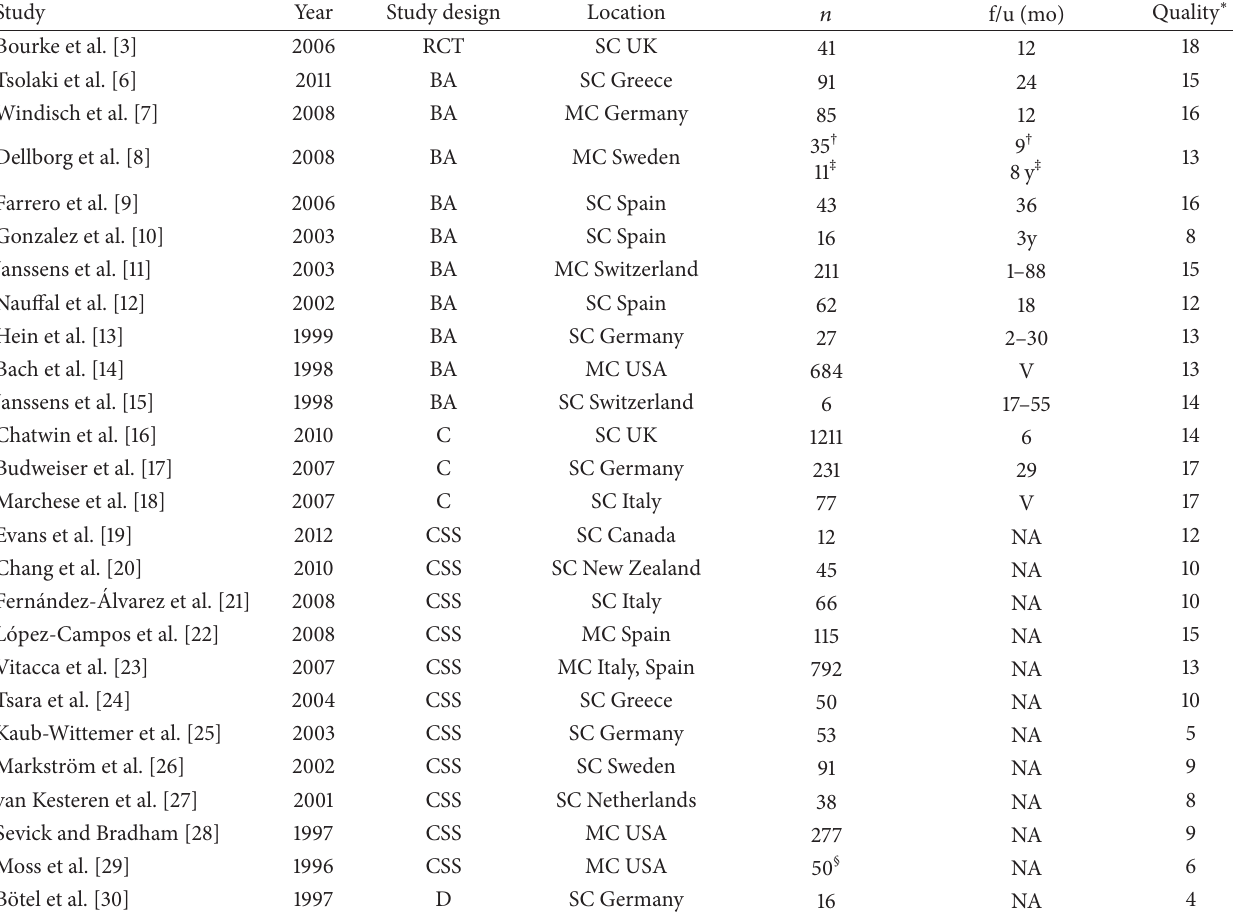
Figure 1: Outline of study selection process. HMV, home mechanical ventilation; HRQL, health related quality of life. ∗ 4 German language studies. Table 1: Study characteristics by study design and year of